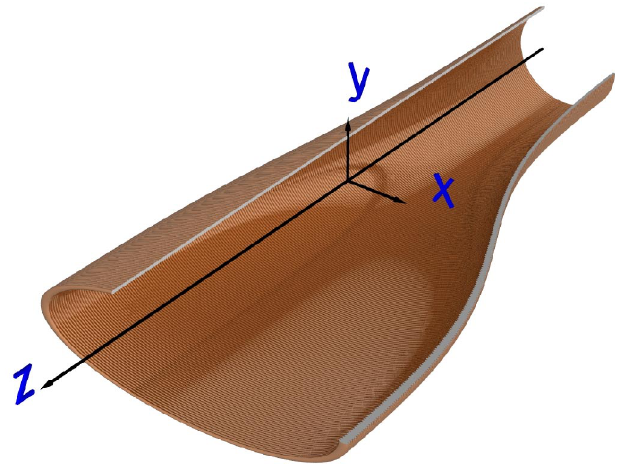
FIG. 1. (Color) A smooth transition of a beam pipe (a cutaway drawing shows the interior part of the